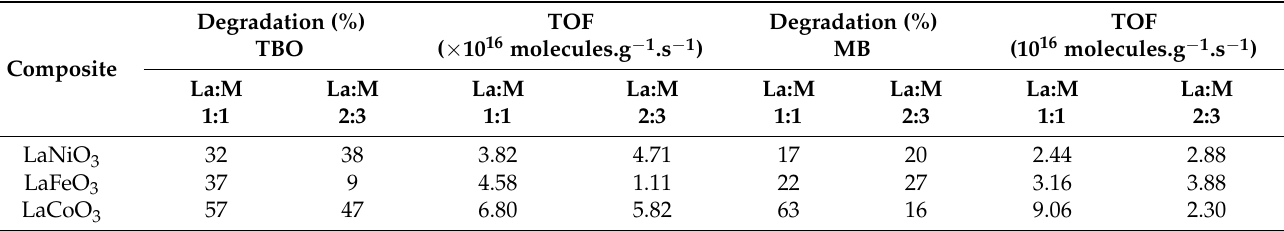
Figure 10. Photocatalytic degradation of MB and o-TB with 30% H 2 O 2 performed under visible light over irradiation time, ( a ) o-TB ratio 1:1, ( b ) o-TB ratio 2:3, ( c ) MB ratio 1:1, and ( d ) MB ratio 2:3. Table 2. Overall degradation percentages for MB and